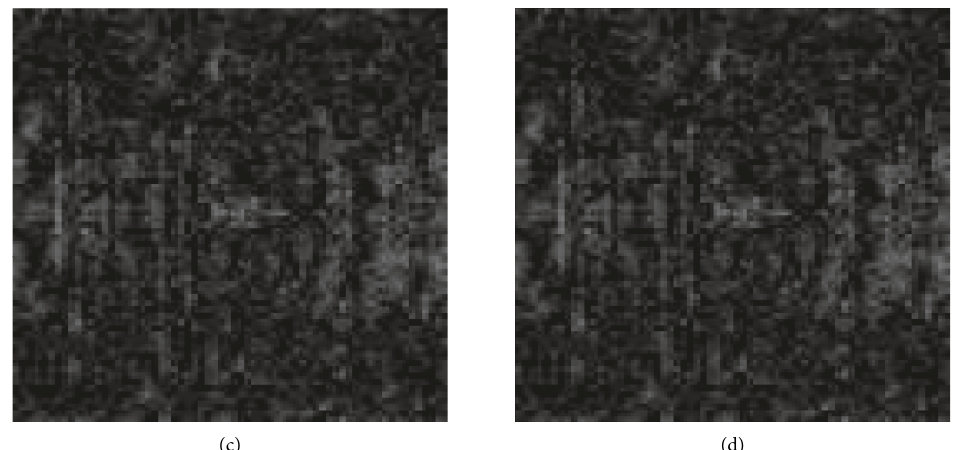
Figure 16: Decrypted results with incorrect radius of P 2D object with incorrect radius ρ respectively.